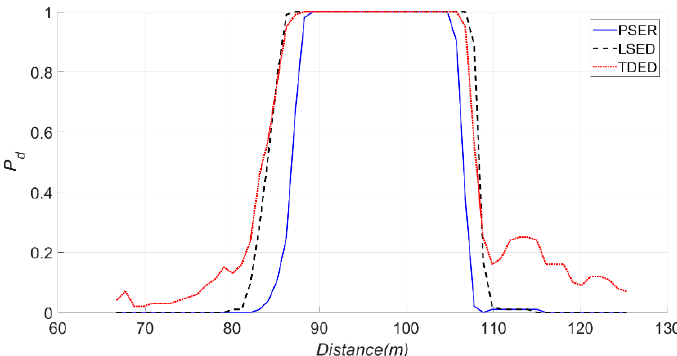
Figure 26. Detection probabilities of the PSER, LSED, and TDED, where the sub-band was 66–105 Hz, N was 1024, and P f was 0.05.